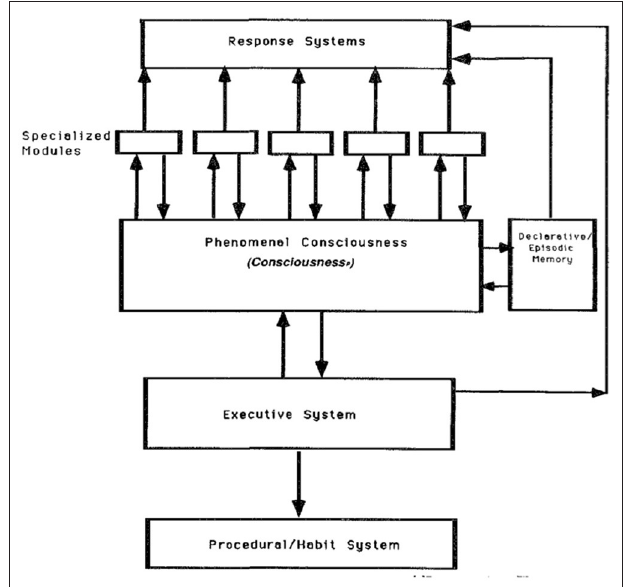
FIGURE 1 | Schacter’s Dissociable Interactions and Conscious Experience (DICE) model form ( Block,